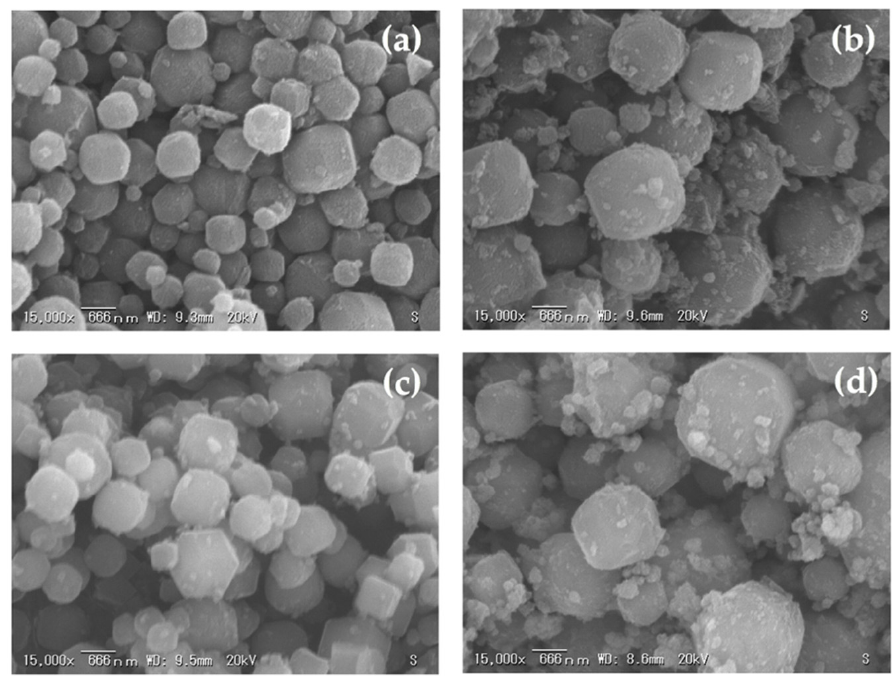
Figure 11. Morphologies of synthesized zeolite A with a curing time of 9.0 h and related phases achieved using different corn stover ash:NaOH ratios: ( a ) corn stover ash:NaOH = 1:0.5, ( b ) corn stover ash:NaOH = 1:1.0, ( c ) corn stover ash:NaOH = 1:1.5, ( d ) corn stover ash:NaOH = 1:2.0.